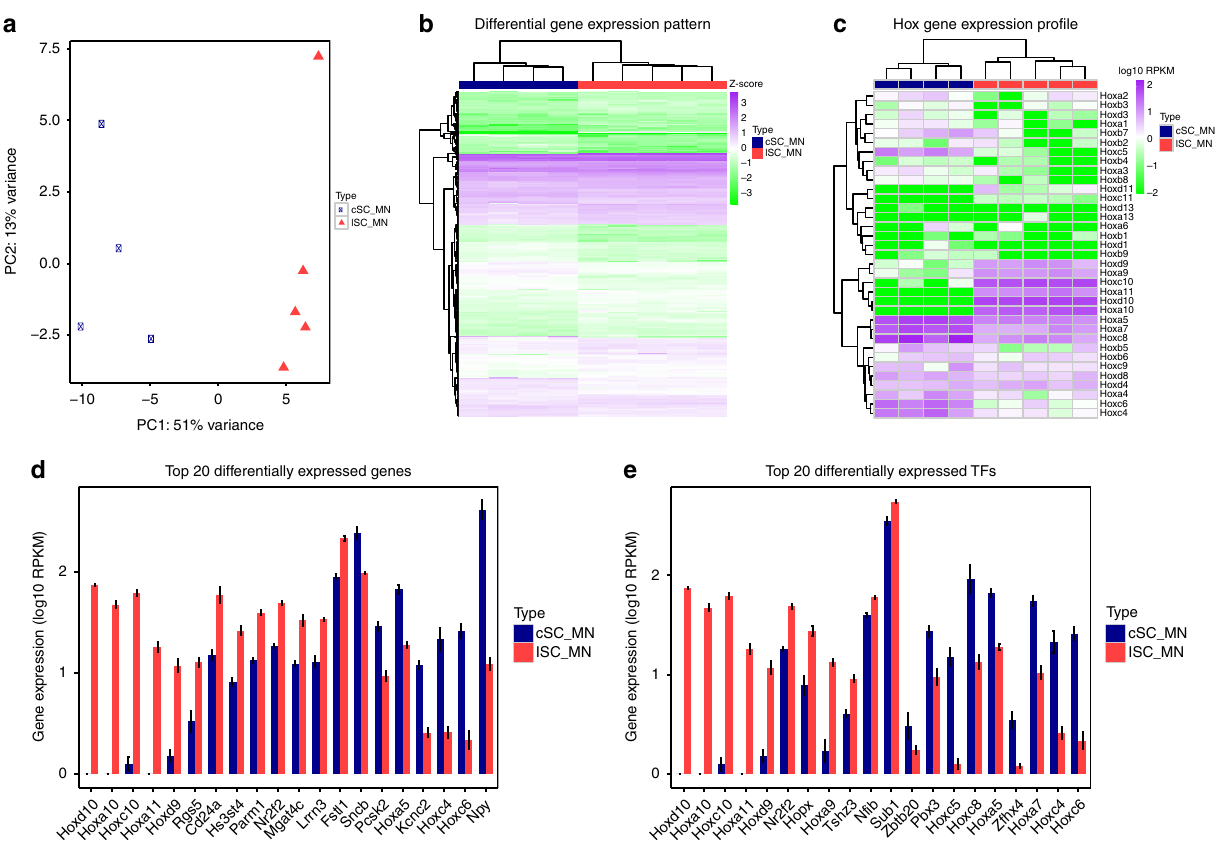
Figure 3 | LCM-seq revealed the unique identities of cervical and lumbar spinal MNs. ( a ) PCA for cSC ( n ¼ 4 mice) and lSC ( n ¼ 5 mice) MNs (120 neurons/sample) based on the top 500 variable genes in expression showed that the two groups separated along the 1st component. ( b ) Genes (899) were differentially expressed between cSC MNs and lSC MNs (adjusted P o 0.05, Wald test). Heatmap shows the Z-score of each gene, which was calculated based on log 10 -transformed RPKM values. ( c ) cSC MNs and lSC MNs showed unique Hox gene expression profiles. ( d ) The top 20 differentially expressed genes between cSC and lSC neurons included eight Hox genes, and for example, Npy , Fstl1 and Sncb (sorted by fold change and adjusted P , shown as mean ± s.e.m.). ( e ) The top 20 differentially expressed transcription factors (TFs) between cSC and lSC neurons included twelve Hox genes and for example, Nr2f2 and Zfhx4 (sorted by fold change and adjusted P , shown as mean ±